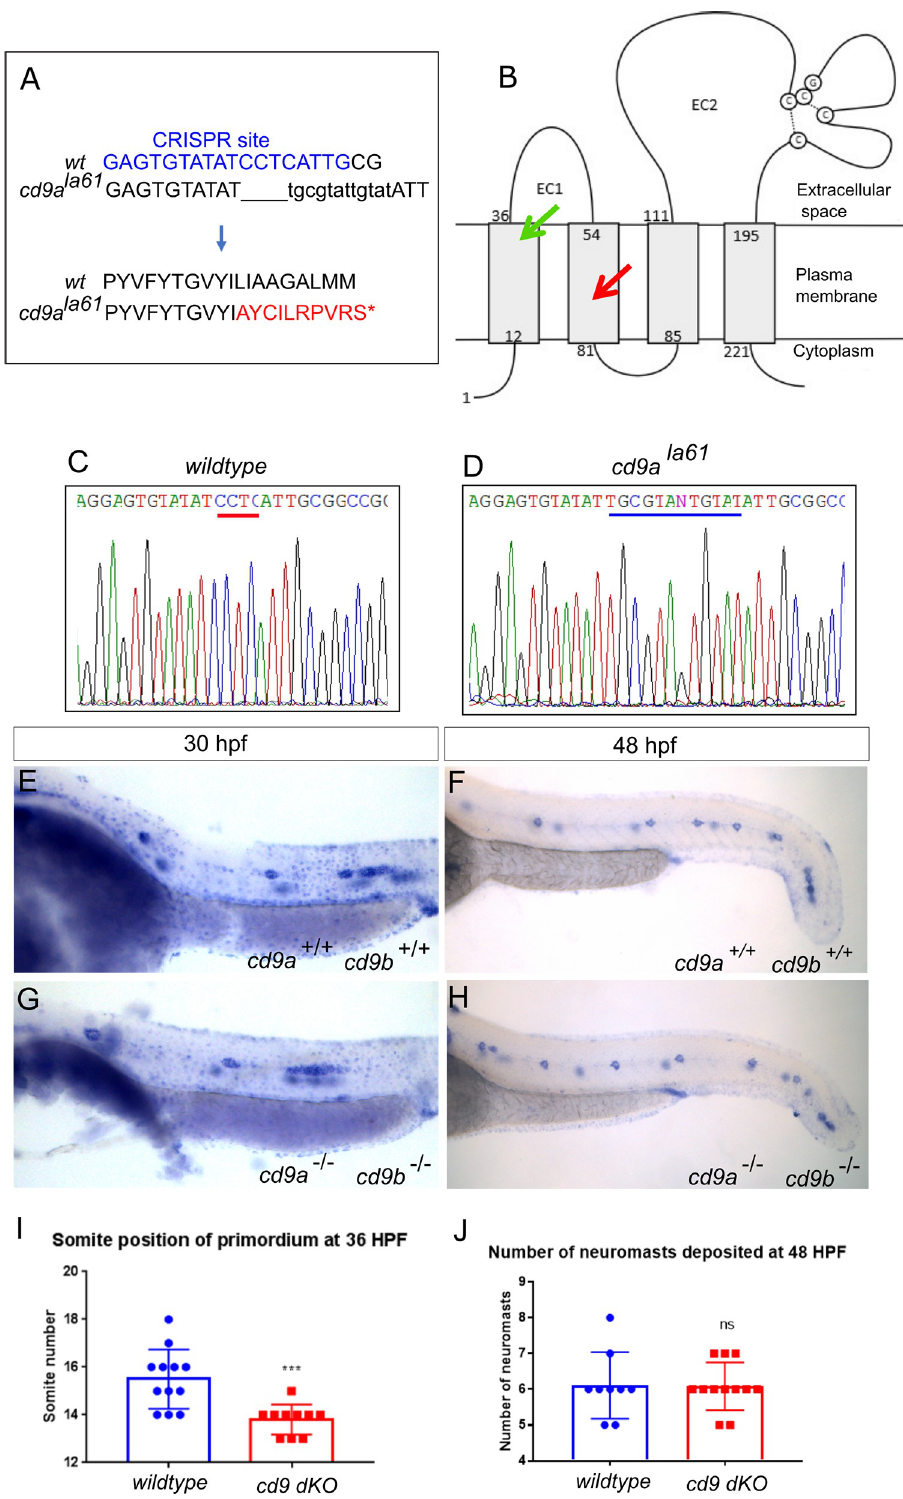
Fig 5. Generation of cd9a mutant in the cd9b pg15 KO background to create a double cd9 KO mutant. A: cd9a mutant allele sequence from exon 3, showing CRISPR target sequence in blue. The 4bp deletion (dashes) and 12bp insertion (lowercase) results in an 8bp insertion as indicated under the WT sequence. This leads to a frameshift